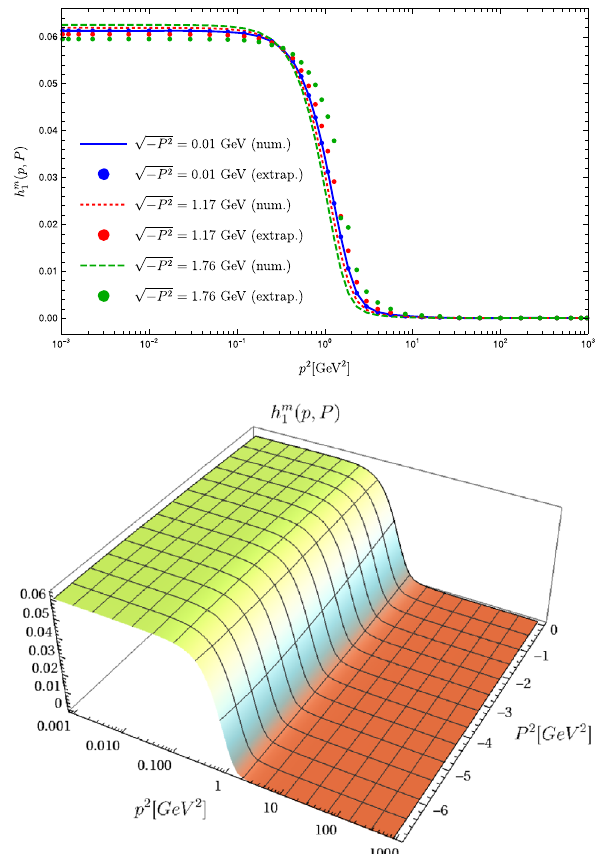
Fig. 10 Top: Comparison of calculated (line) and extrapolated (dots) leading meson amplitudes at selected values of P 2 . Bottom: Leading meson amplitude at time-like momenta P